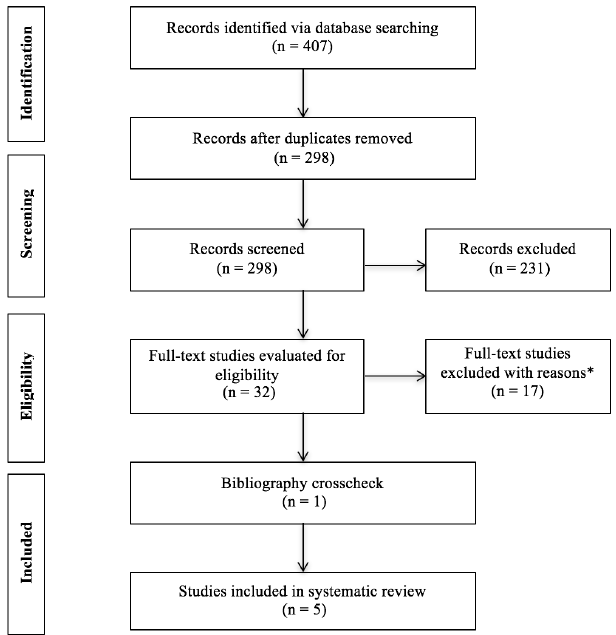
Figure 1. PRISMA flow diagram of studies through the review process; * reasons for study exclusion included non-English language articles, ineligible VR type (i.e., non-immersive VR), and no measures of anxiety and depression. Many studies were excluded for multiple reasons.